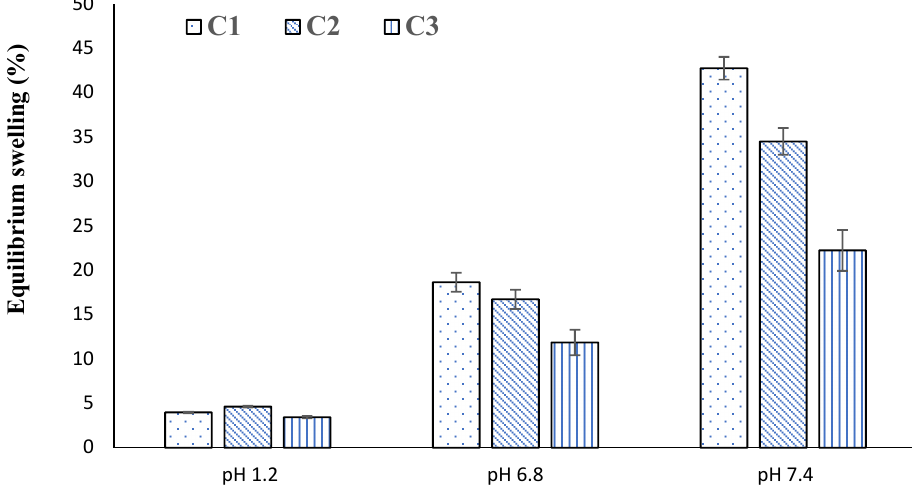
Figure 6. Effect of GA over dynamic swelling of 5-FULH.